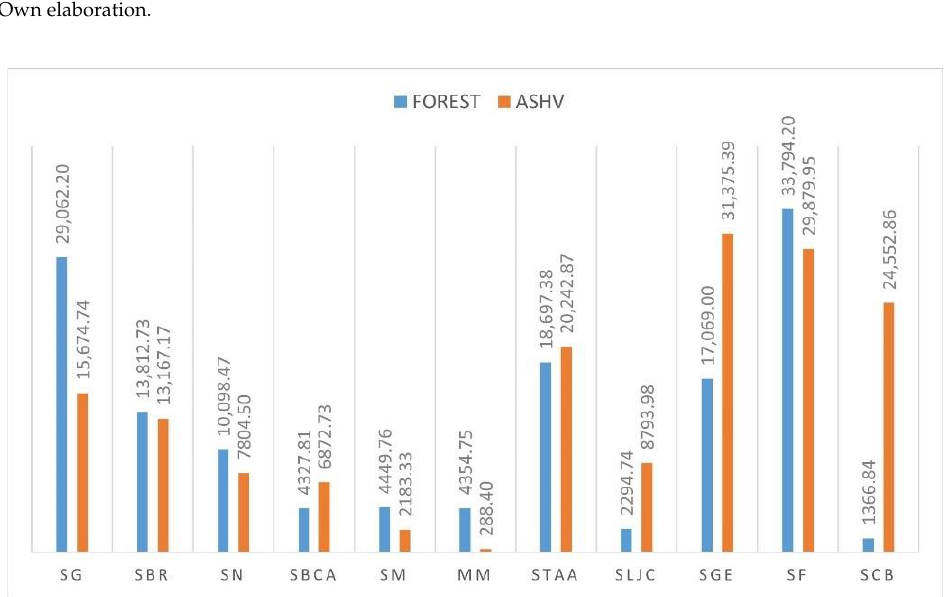
Figure 11. Current surfaces of the main vegetation cover in the natural areas in hectares (2021). Legend: SG: Sierra de Grazalema; SBR: Sierra Bermeja and Real; SN: Sierra de las Nieves; SBCA: Sierra Blanca, Canucha, and Alpujata; SM: Sierra de Mijas; MM: Montes de M á laga; STAA: Sierra de Tejeda, Almijara, and Alhama; SLJC: Sierra de L ú jar, Jol ú car, and El Conjuro; SGE: Sierra de G á dor y Enix; SF: Sierra de Filabres; SCB: Sierra de Cabrera y B é dar. Own elaboration based on data of Cartography of the Uses and Vegetation Covers of the soil of Andalusia (1991) and the Geographical Information System for the Identification of Agricultural Land Parcels (SIGPAC)